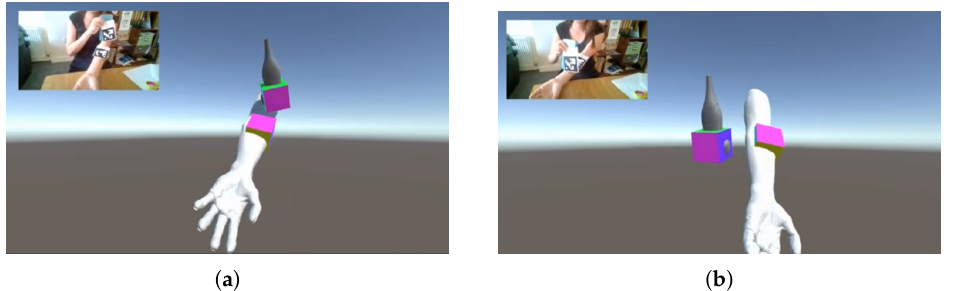
Figure 3. Issue of occlusion when using two ArUco markers for the tracking. ( a ) Tracking of the arm and the ultrasound probe using ArUco markers; no occlusion. ( b ) Tracking of the arm and the ultrasound probe using ArUco markers; occlusion of the arm marker by the probe marker and impact on the tracking of the arm in the virtual scene which no longer follows the arm of the